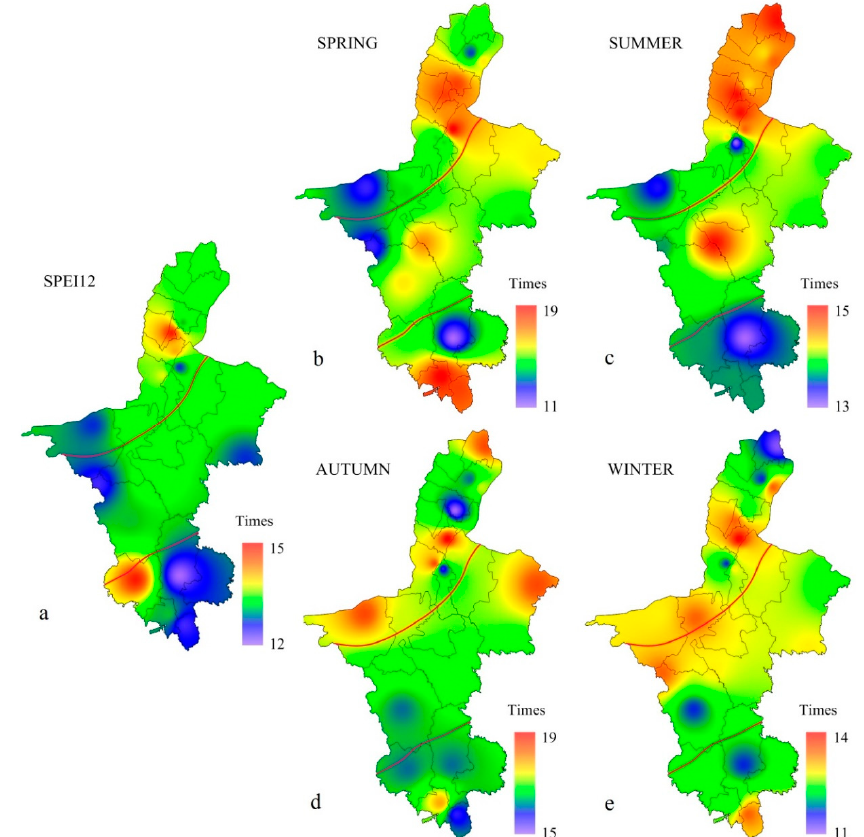
Figure 7. Spatial distribution of drought occurrence times based on SPEI12 and SPEI3 values during 1960–2016. ( a ) The SPEI12 values were used to calculate the interannual average values; ( b – e ) the SPEI3 values were used to calculate the interannual average values in each season.